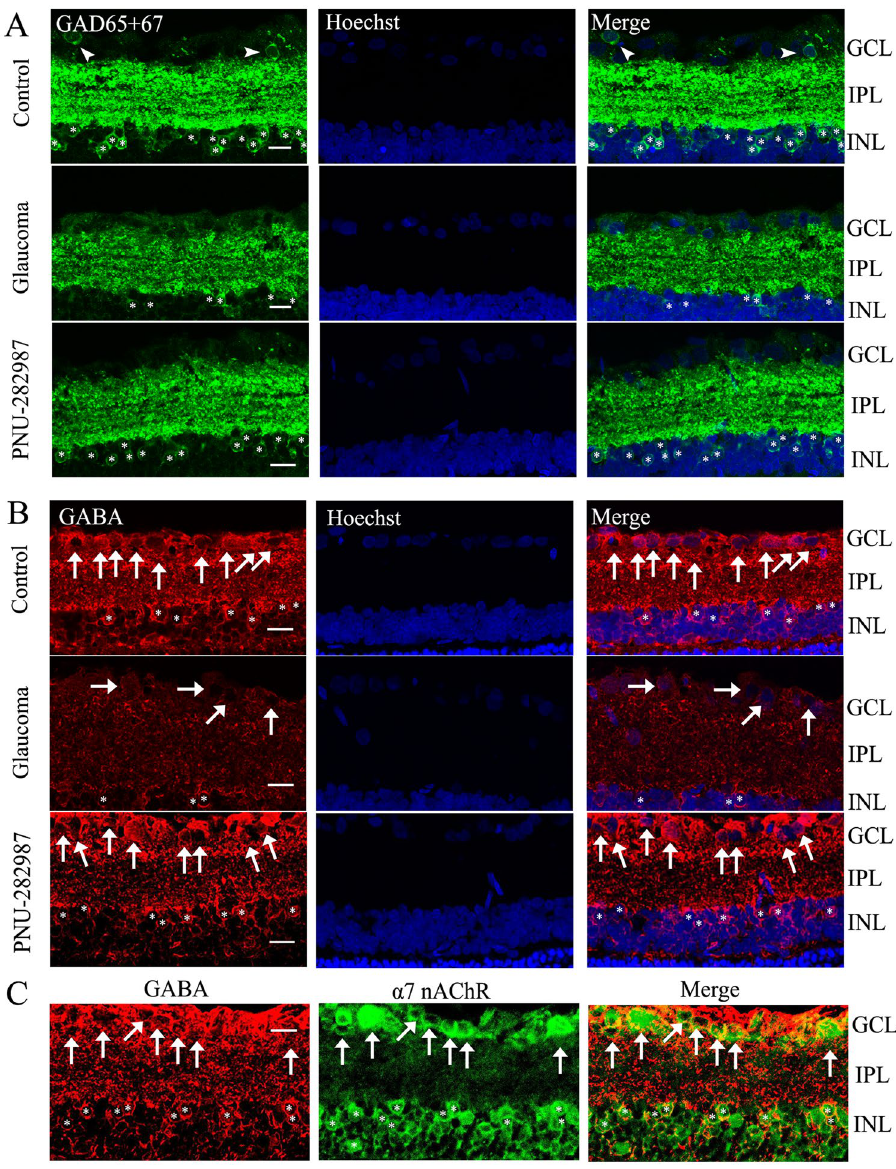
Figure 5. PNU-282987 prevents reductions in GAD65/67 and GABA immunoreactivity caused by chronic ocular hypertension. ( A,B ) Micrographs of 10 μ m thick transverse sections of retinas from control and glaucomatous rats. ( A ) Compared with control retina (top panels in A), GAD65/67 immunoreactivity is reduced in glaucomatous retina (middle panels in A), corresponding to reduced expression in the INL (asterisks), inner plexiform layer (IPL), and GCL (arrowheads) of the glaucomatous retina. These effects of ocular hypertension are prevented by administration of PNU-282987 (bottom panels in A). ( B ) GABA immunohistochemistry is decreased in the glaucomatous retina (middle panels in B, arrows, asterisks) relative to controls (top panels in B, arrows, asterisks). PNU-282987 (bottom panels in B, arrows, asterisks) prevents the effects of ocular hypertension on GABA expression. ( C ) Double-label immunohistochemistry shows that GABA (red) is colocalized with α 7-nAChRs (green). Scale bar, 15 μ m. INL, inner nuclear layer; IPL, inner plexiform layer; GCL, ganglion cell layer. The arrowheads indicate sparse amacrine cells, arrows indicate RGCs, and asterisks indicate amacrine